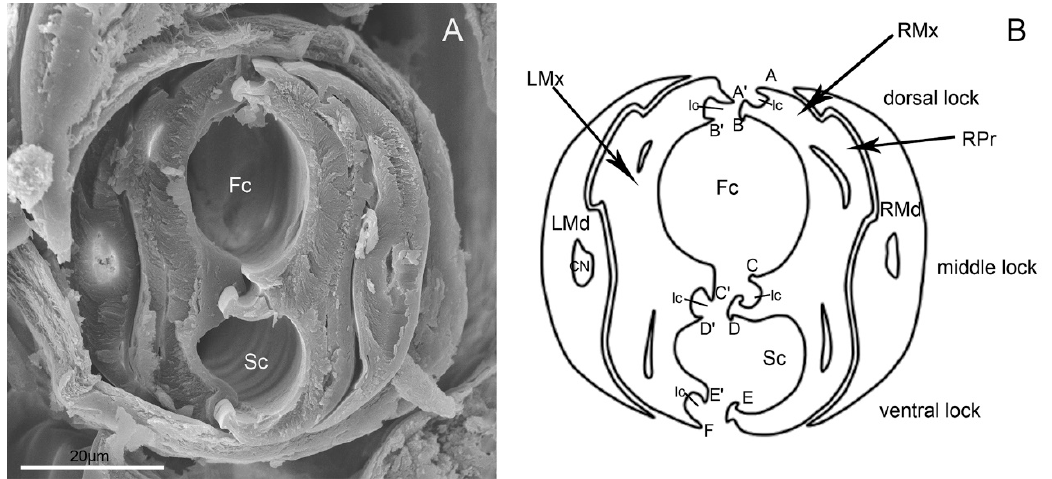
Figure 10. Cross-section of stylet fascicle of E. fullo . ( A ) Cross-section of stylet fascicle through middle of second and third segment showing food canal (Fc) and salivary canal (Sc); ( B ) Diagram of